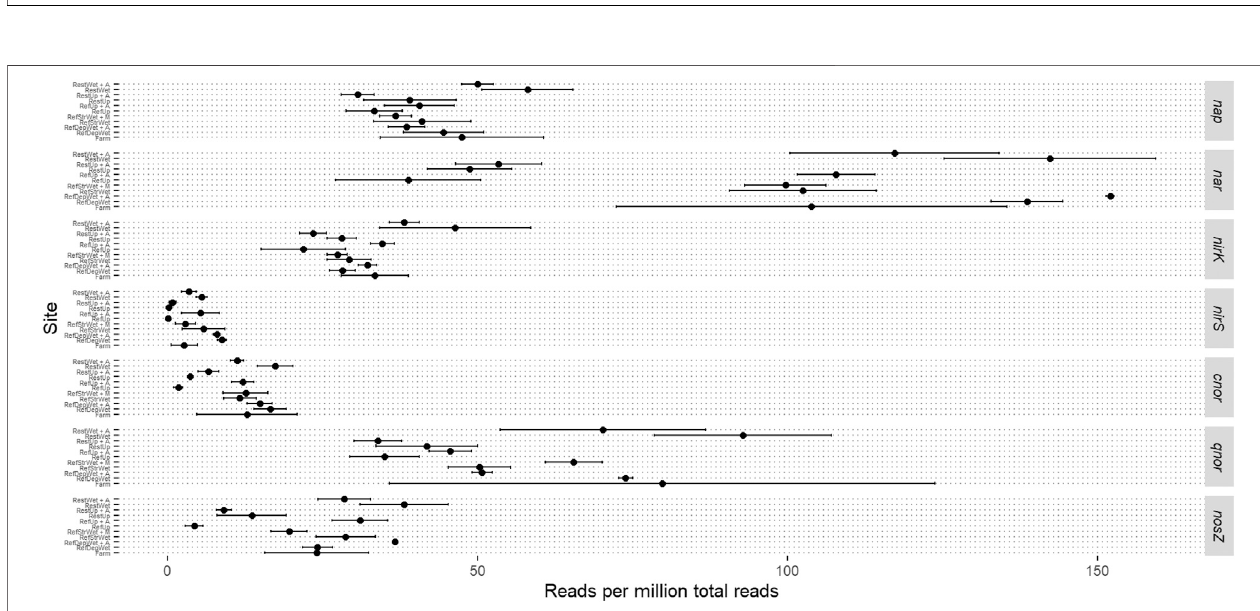
FIGURE3| PCAplotofmetagenomicsamplecompositionfromthe11sitesusingtotalmetagenomicreads.Triplicatereadsetswereconcatenatedintoonesetfor this comparison giving one point per site. Sample abbreviations are: RestUp – Restored Upland, RefUp – Reference Upland, RestWet – Restored Wetland, RefStrWet – Reference Streamside Wetland and RefDepWet – Reference Depressional Wetland.